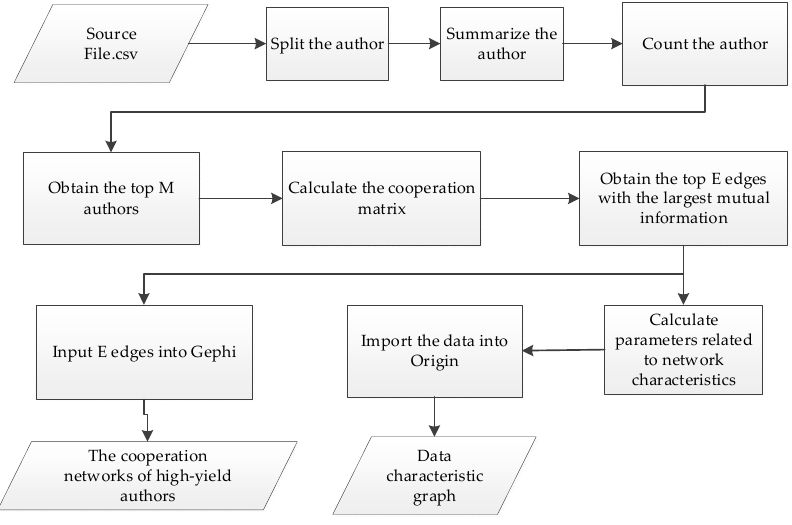
Figure 1. The process of constructing and analyzing the author cooperation network.